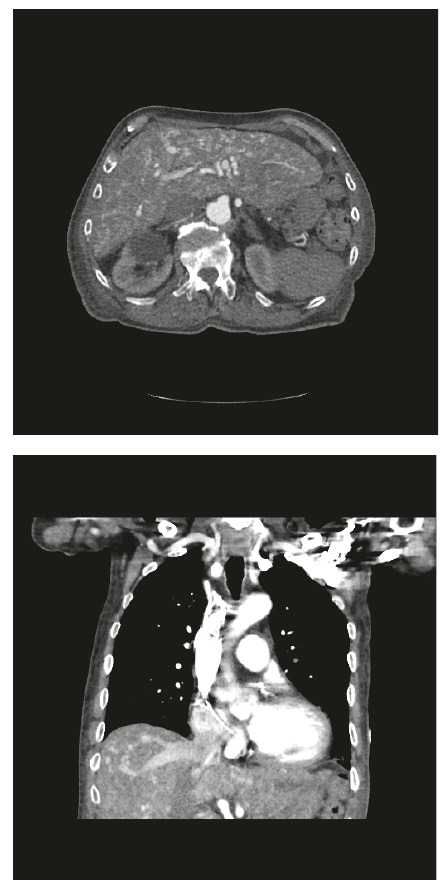
Figure 2: Computed Tomography in the axial (a) and coronal (b) arterial phase images showing an increased number of opacified hepatic arteries with early opacification of draining veins, consistent with multiple hepatic